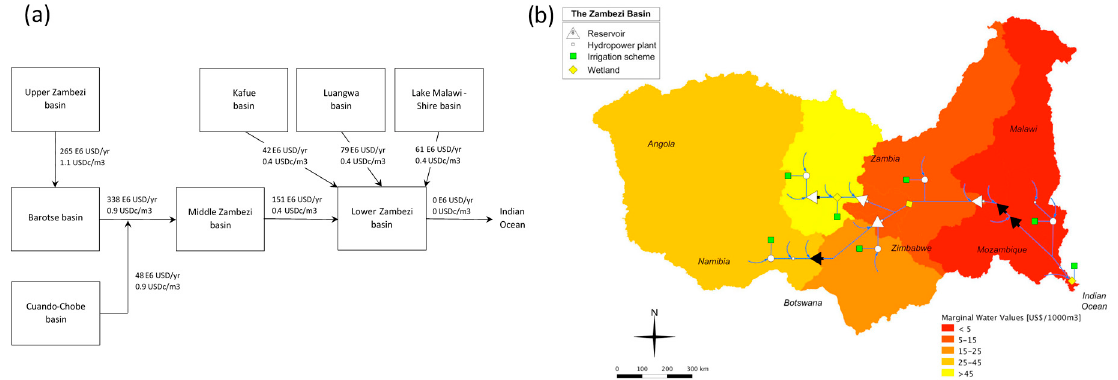
Figure 1. Estimates of the spatial distribution of the water value in the Zambezi basin: ( a ) total value (million US$/yr) and average value per unit of river runoff (US$ cents/m 3 ) per sub-basin in 1990 (source: Figure 6 in [13]); ( b ) projected future marginal water values (full development of hydropower and irrigation potential) (US$/1000 m 3 ) (source: Figure 6 in [17]).